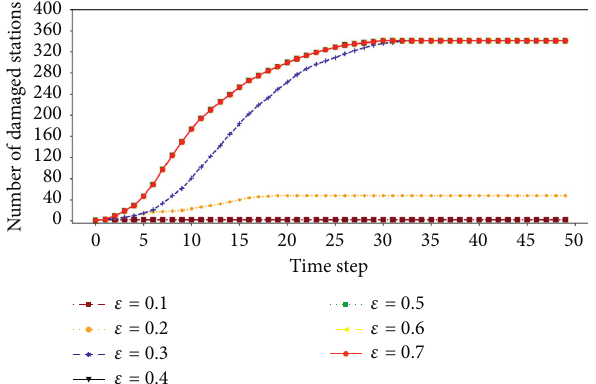
Figure 7: Network cascading failure processes caused by the Pudong Avenue Station under different ε values with R �